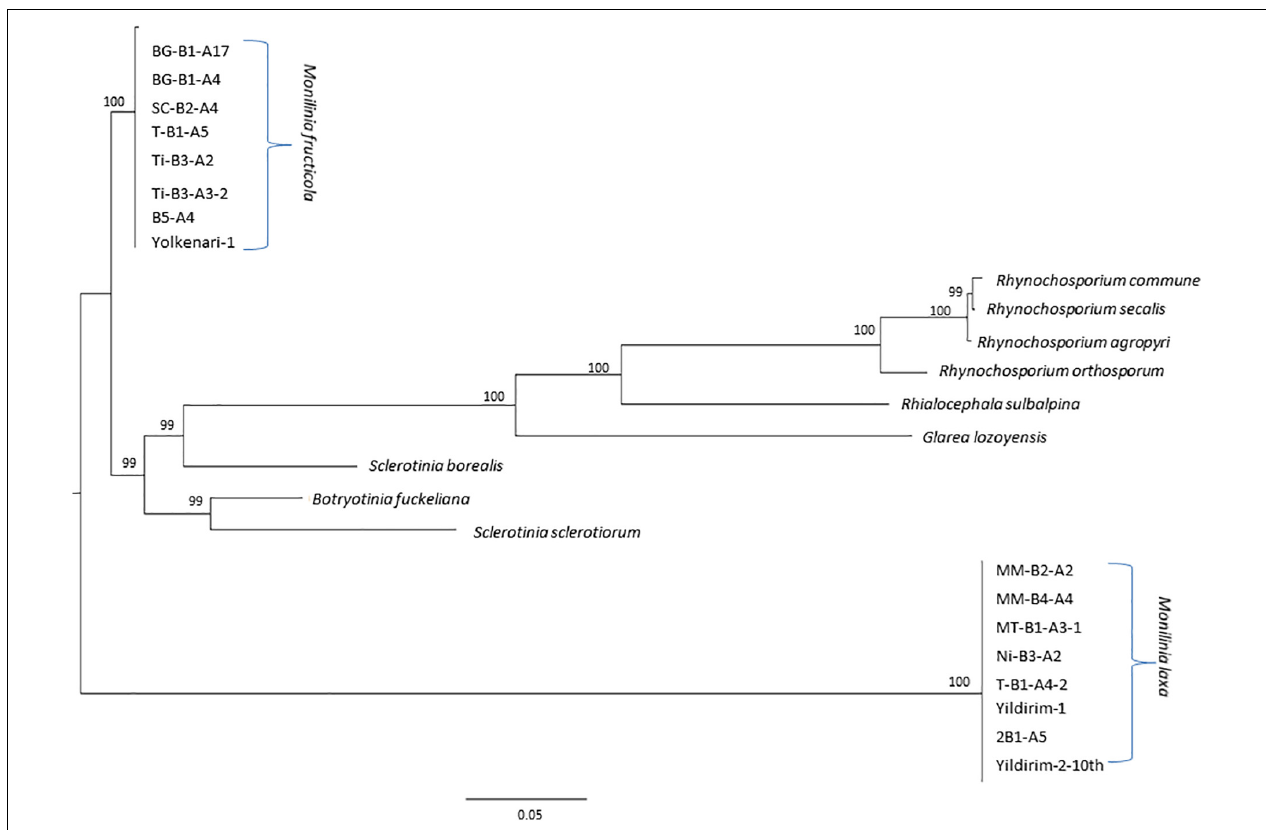
FIGURE 7 | Maximum likelihood tree inferred from the dataset of amino acid sequences of the 14 core mitochondrial genes and ribosomal protein for Monilinia isolates used in this study and other species of the Helotiales obtained from the NCBI GenBank. Node numbers show bootstrap support values. Concatenated order follows as cox1 , nad4 , cob (cytb) , atp9 , nad2 , nad3 , cox2 , nad4l , nad5 , nad6 , cox3 , nad1 , atp8 , atp6 , and rps3 . Node numbers show bootstrap support values.